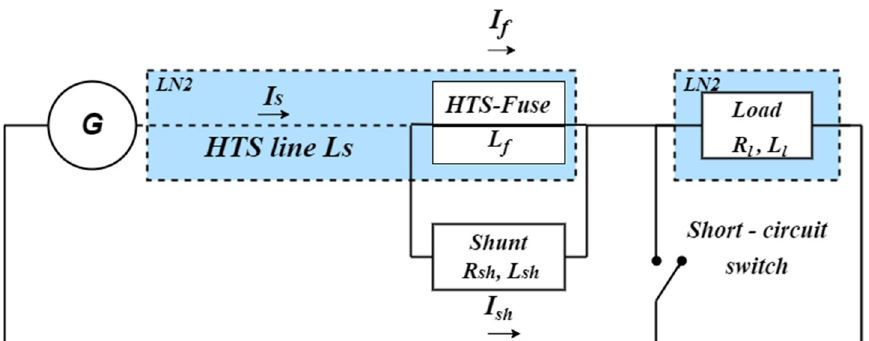
Figure 1. Schematic diagram of the single-phase short-circuits imitation.: U G , R G , L G are, respectively, the voltage, active resistance and inductance of the generator, R L , L L —are, respectively, the active resistance and inductance of the load, I S is the total network current, L F , I F are, respectively, the inductance and current of the fuse box, R SH , L SH and I SH are, respectively, the active resistance and inductance of the shunt, L C is the cable inductance.